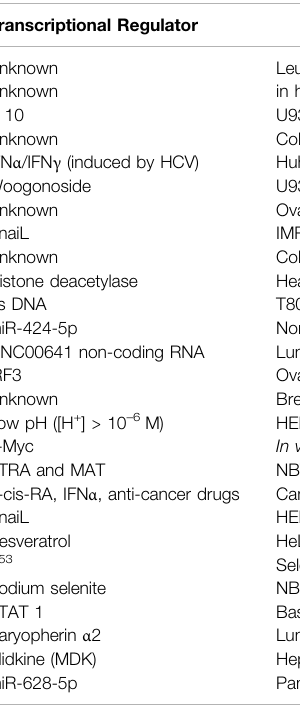
TABLE 1 | Transcriptional regulators of